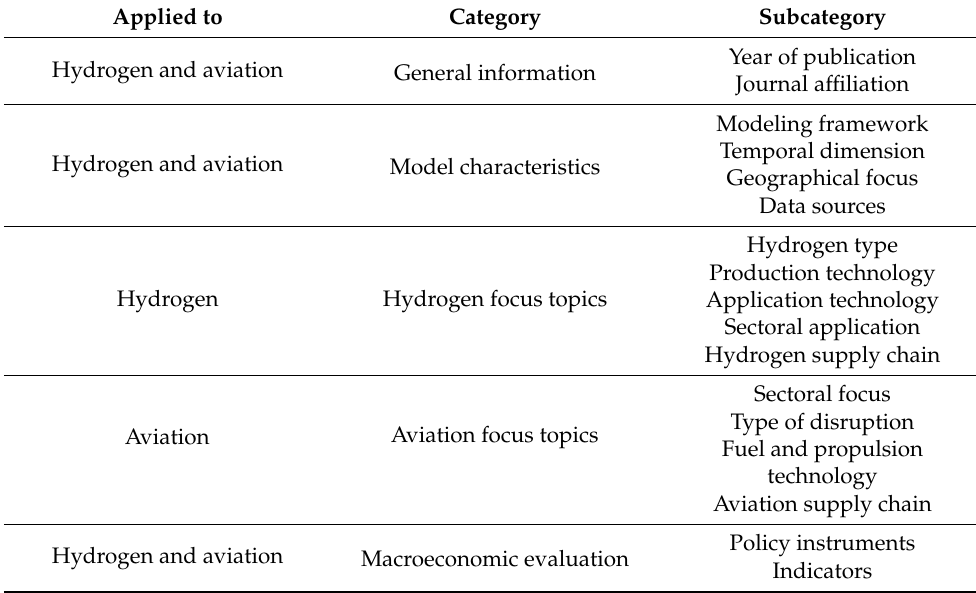
Table 1. Overview of categories and subcategories applied to analyze the articles included.